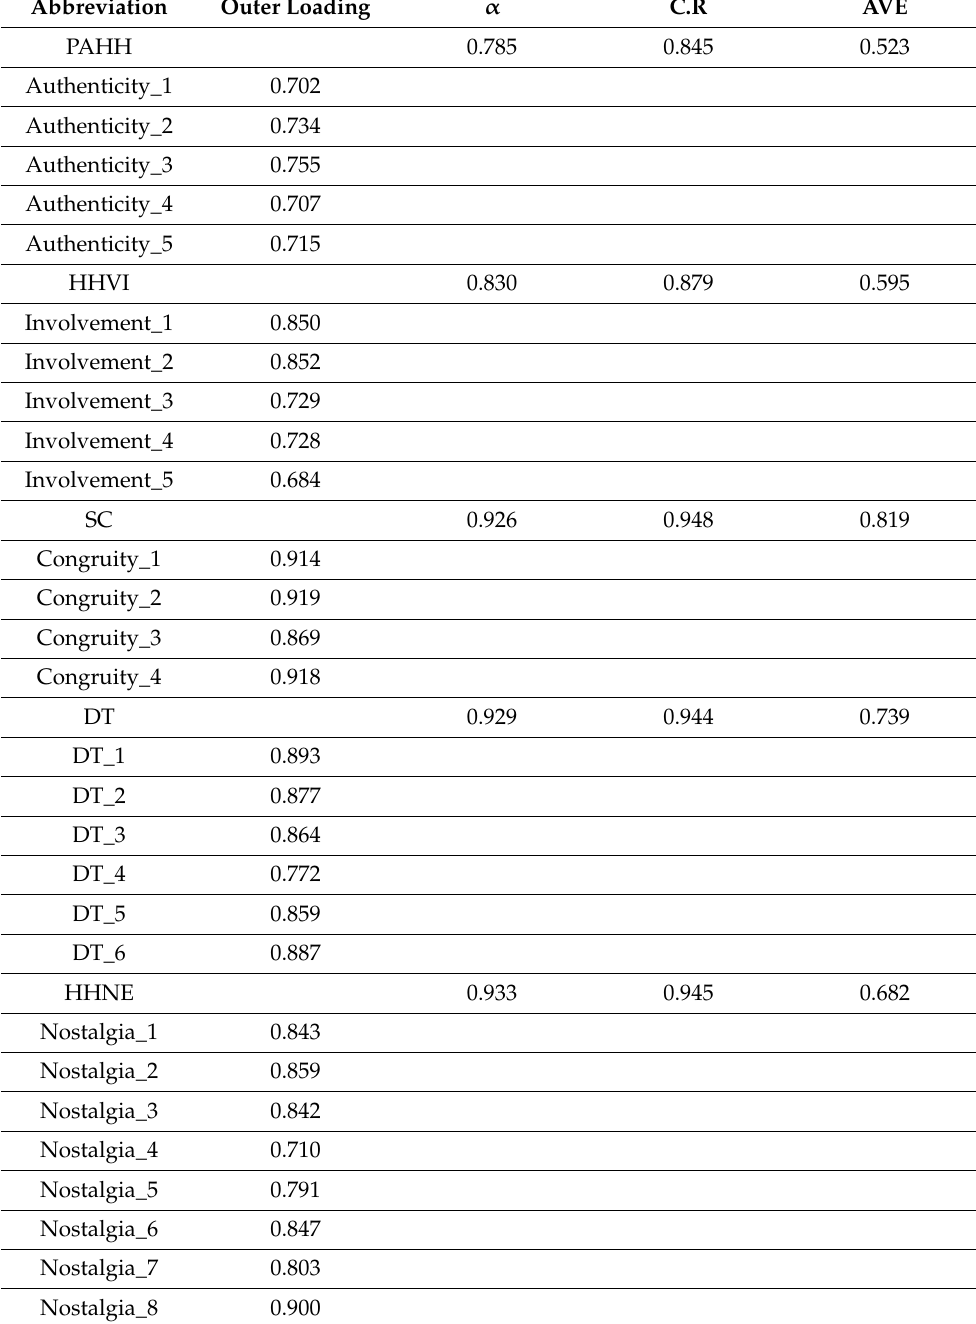
Table 1. Evaluation of the measurement